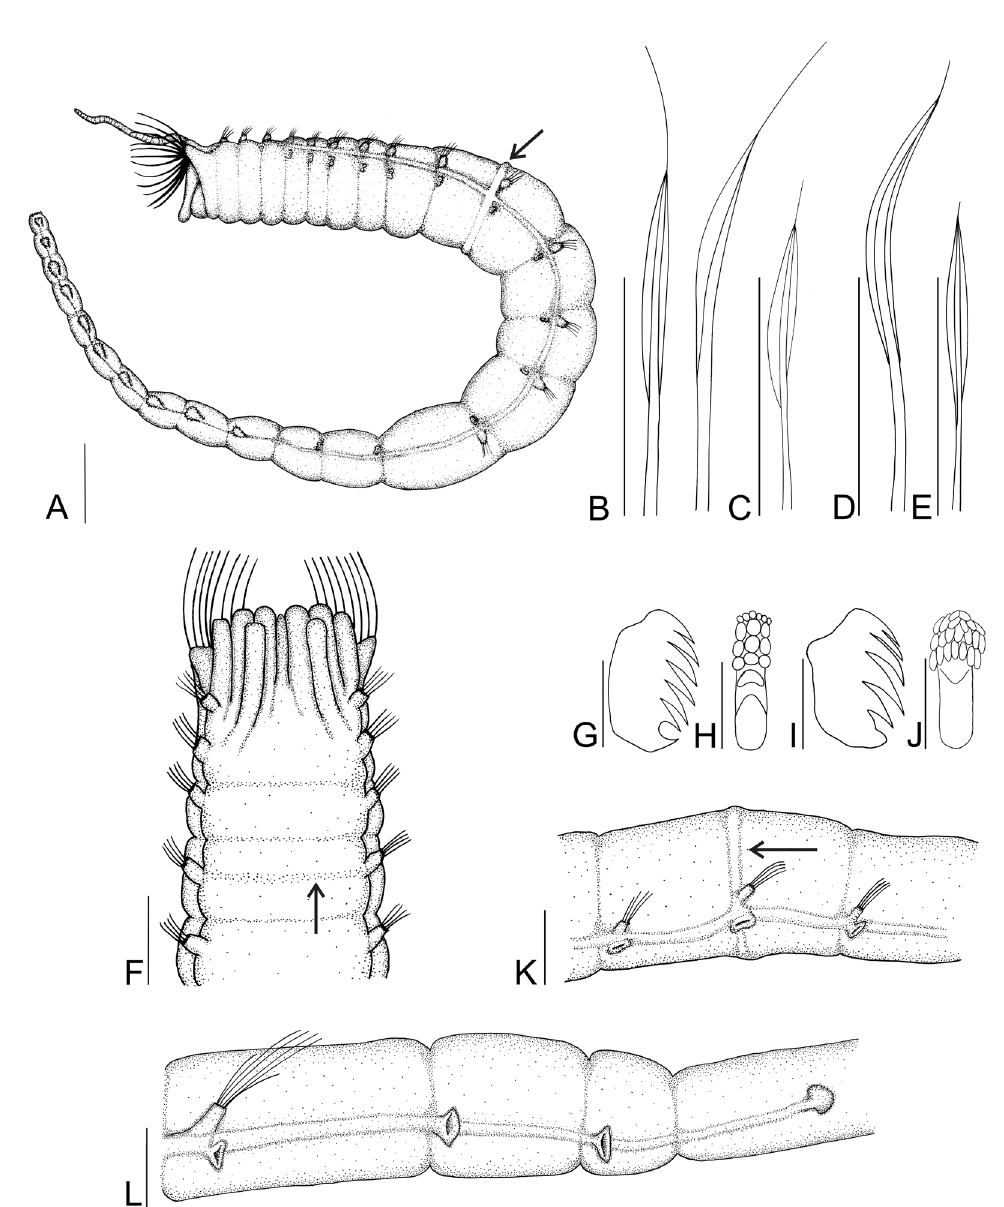
Fig. 4. Anobothrus konstantini Säring & Bick sp. nov. A . Complete specimen with one outermost branchia, lateral view, arrow: dorsal ridge on segment 12 (TC 11, TU 7), additional material (ZSRO-P2657). B . Long thoracic notochaeta, additional material (ZSRO-P2658). C . Short thoracic notochaeta, additional material (ZSRO-P2658). D . Long notochaeta of the modified segment 12 (TC 11, TU 7), additional material (ZSRO-P2658). E . Short notochaeta of the modified segment 12 (TC 11, TU 7), additional material (ZSRO-P2658). F . Dorsal view of the anterior end, paratype (ZSRO-P2662). G . Lateral view of thoracic uncinus, additional material (ZSRO-P2658). H . Frontal view of thoracic uncinus, additional material (ZSRO-P2658). I . Lateral view of abdominal uncinus, additional material (ZSRO-P2658). J . Frontal view of abdominal uncinus, additional material (ZSRO-P2658). K . Lateral view of three thoracic segments, arrow: dorsal ridge on segment 12 (TC 11, TU 7) with slightly elevated notopodia, additional material (ZSRO-P2656). L . Lateral view of last thoracic, two intermediate and first abdominal segments, paratype (ZSRO-P2663). Scale bars: A = 500 µm; B–E = 100 µm; F, K = 200 µm; G–H = 10 µm; I–J = 5 µm; L = 50